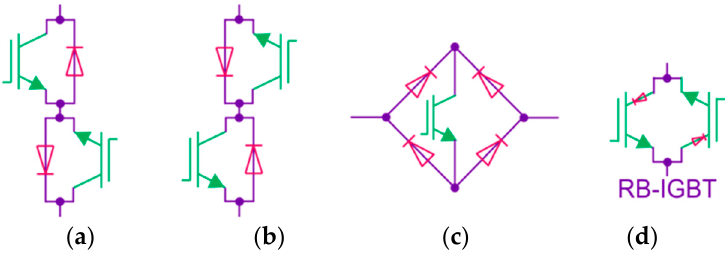
Figure 5. Bi-directional switches: ( a ) Common emitter IGBT, ( b ) common collector IGBT, ( c ) IGBT with a diode bridge, and ( d ) RB-IGBT reverse blocking IGBTs.